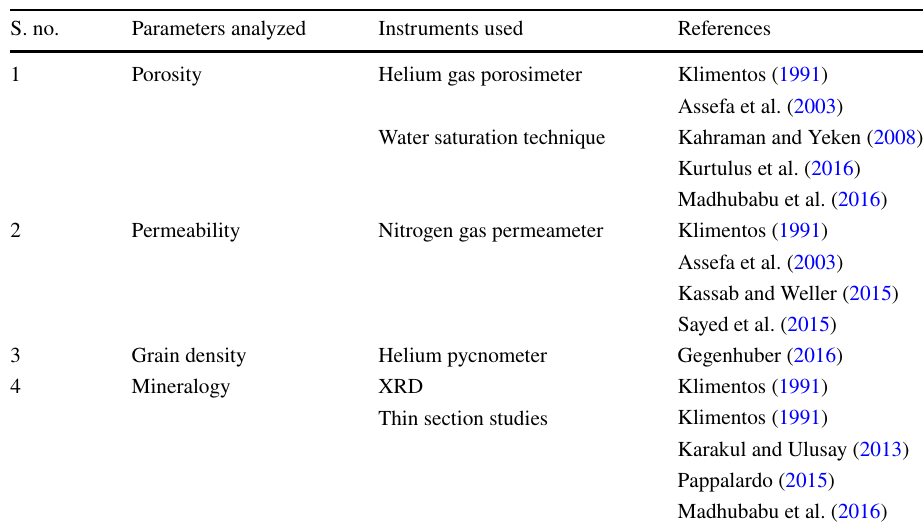
Table 3 Instruments/tests used/conducted related to petrophysical properties to derive datasets relevant to this